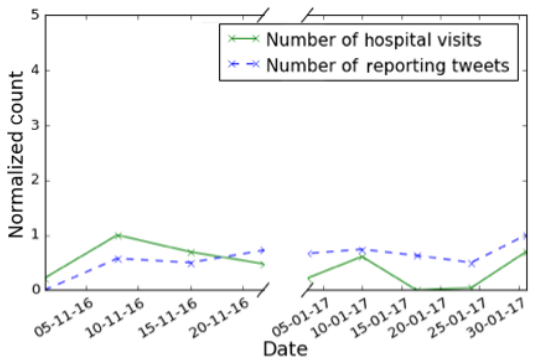
Fig. 8 Count of combined English and Arabic tweets (classified as nonself) versus count of actual hospital visits.